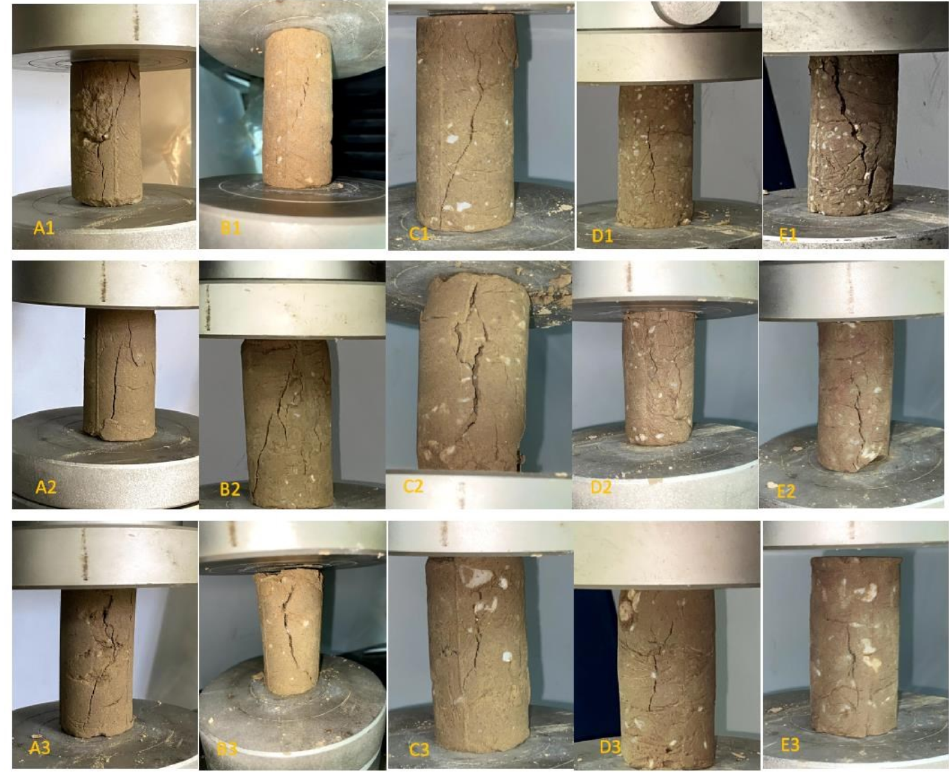
Figure 2. Results of unconfined compression test of soil–rock mixture (See Table 2 for the sample corresponding to each